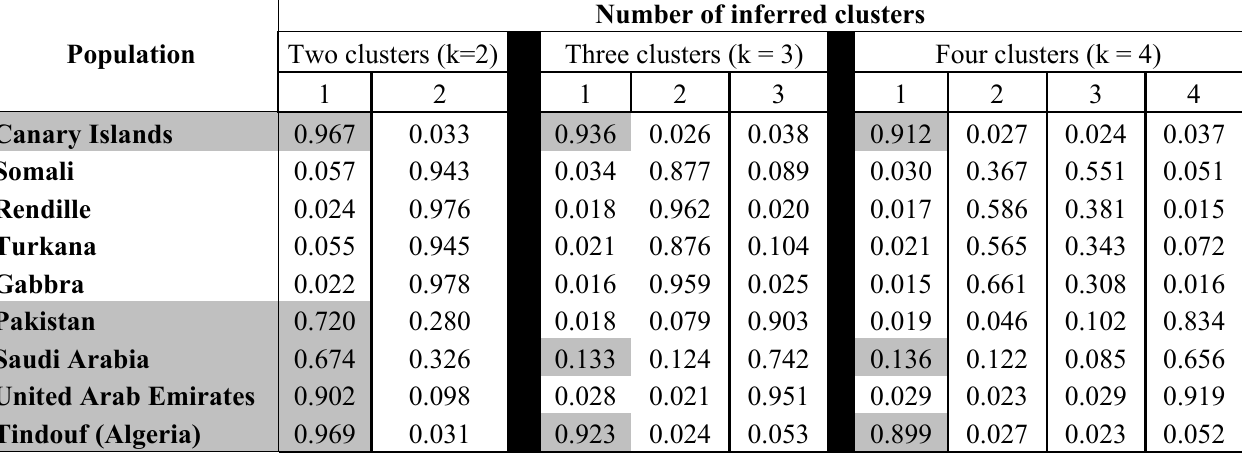
Table 4. Estimated membership fractions of camel populations for each of the k inferred clusters with k from 2 to 4. The membership fractions greater than 10 % sharing the same cluster as the Canarian population are